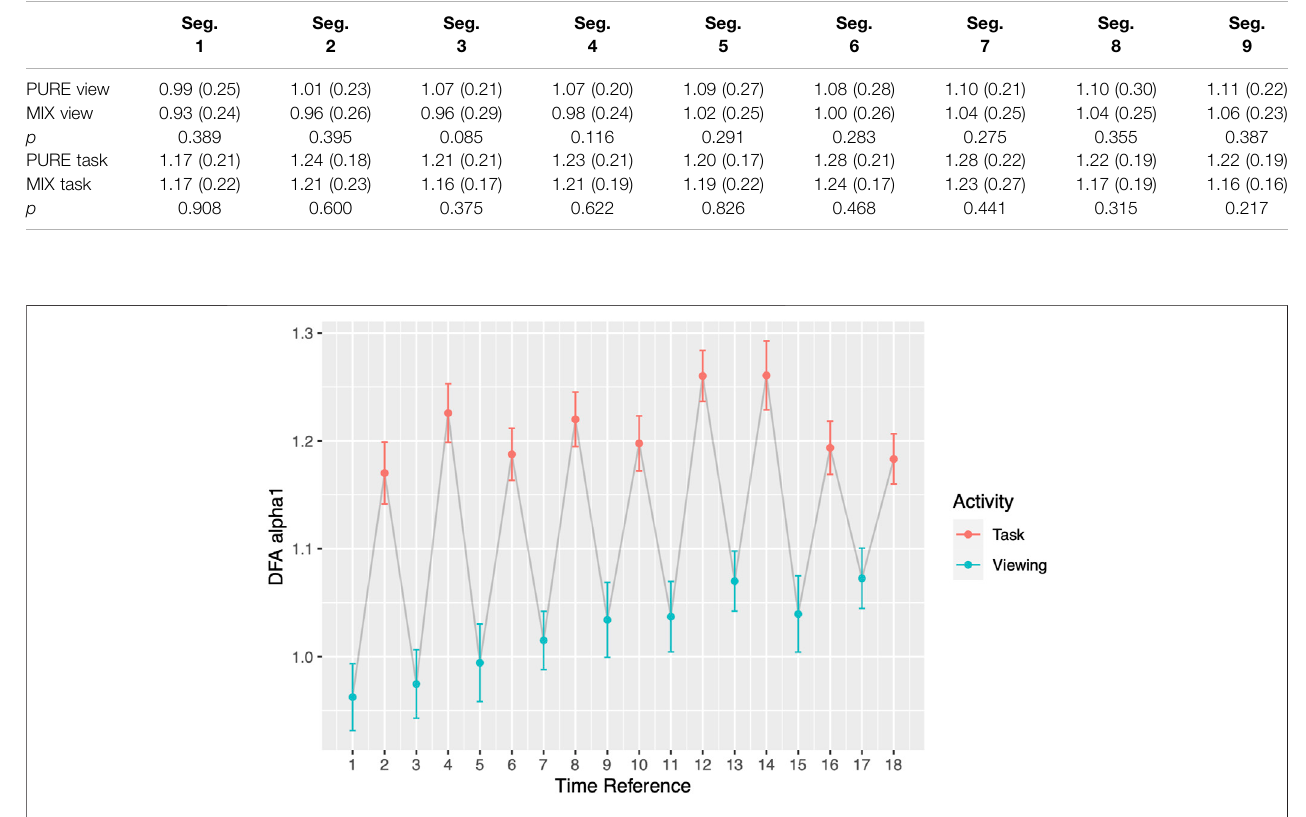
FIGURE 3 | DFA α 1 by segments. Odd Time References represent Viewing; even Time References represent Task. Grey line connects activities chronologically.